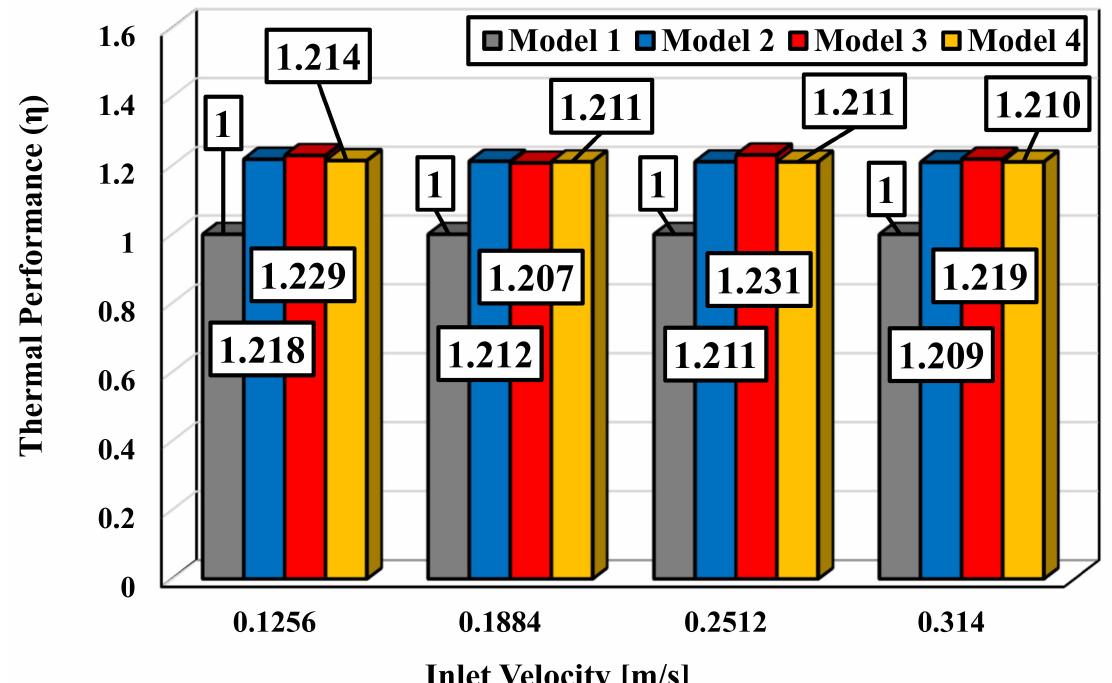
Figure 11. The thermal performance ( η ) versus inlet velocity for various models.